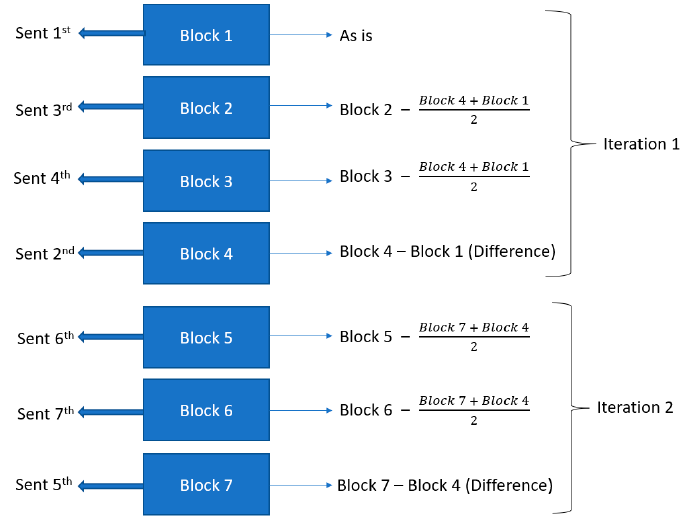
Figure 1. Example of using H.264 concept.